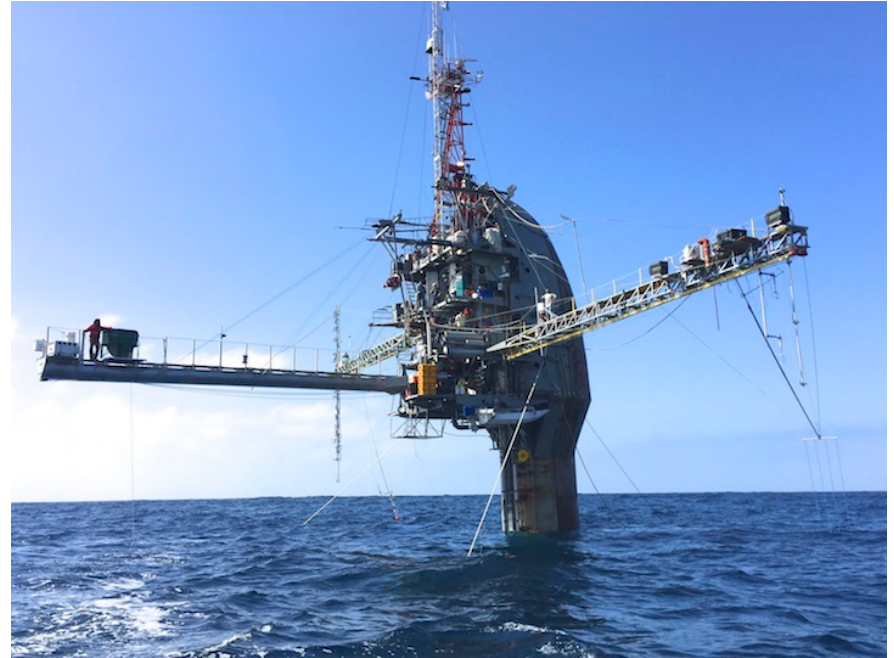
Figure 1: FLIP upright, at sea. Photo by the author.